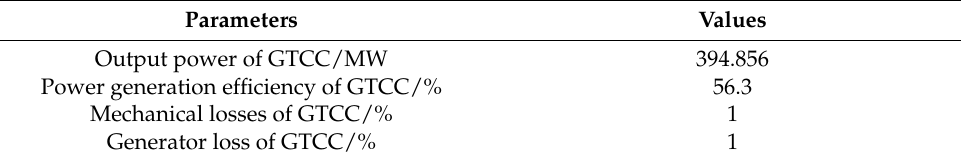
Table 4. Design parameters of GTCC.